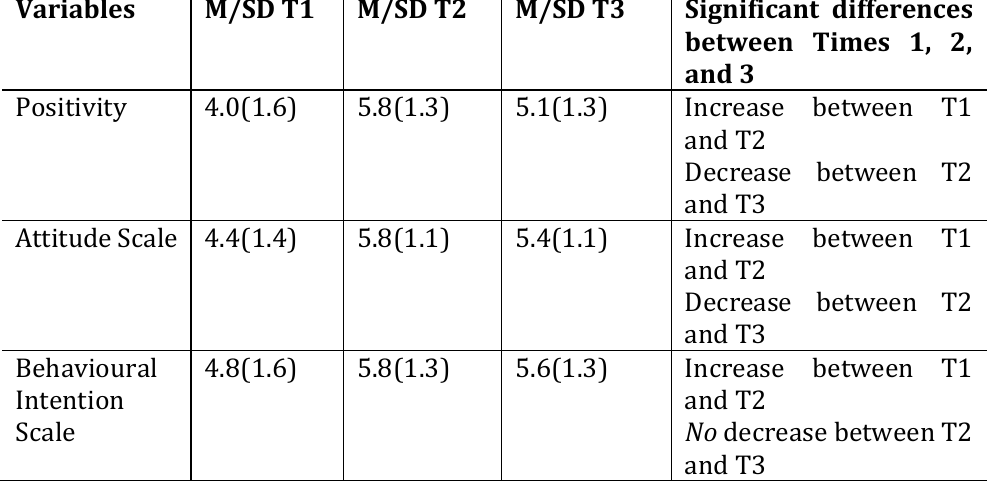
Descriptive characteristics and repeated measures ANOVAs (Time 1, 2, and 3)